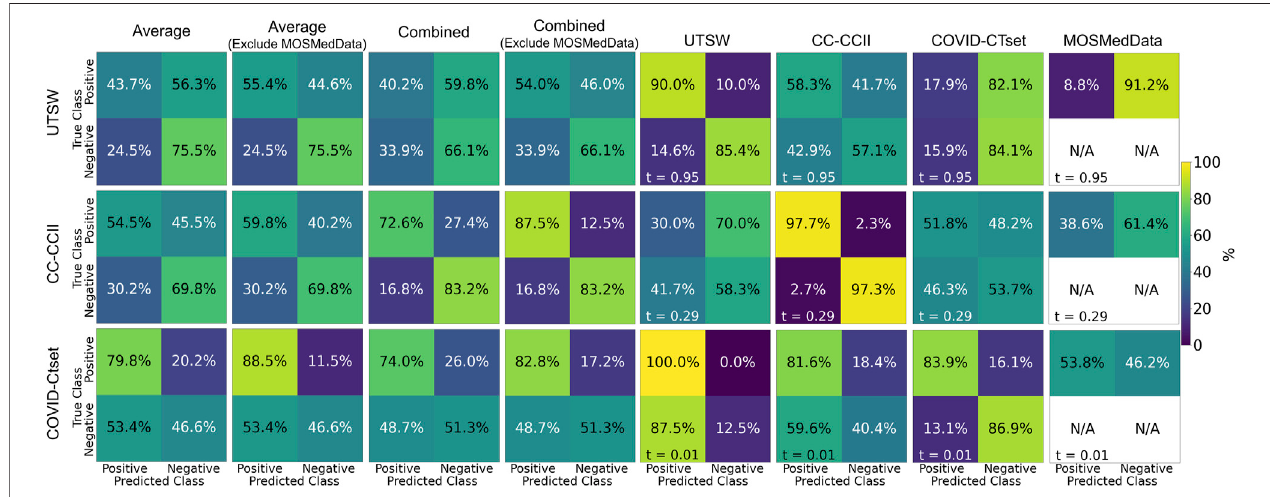
FIGURE3| Confusionmatricesonthetestdataforeachofthemodelstrainedonasingledataset.Eachrowrepresentsthedatasetsthatthemodelwastrainedon, and each column represents the datasets that the model was evaluated on. Note that MosMedData does not have any negative label data. The labeling threshold used foreachmodelisindicatedonthelowerleftofeachconfusionmatrix( t (cid:2) #).The “ Average ” confusionmatrixisanequallyweightedaverageamongeachdataset,whilethe “ Combined ” confusion matrix is calculated from all samples from the datasets.